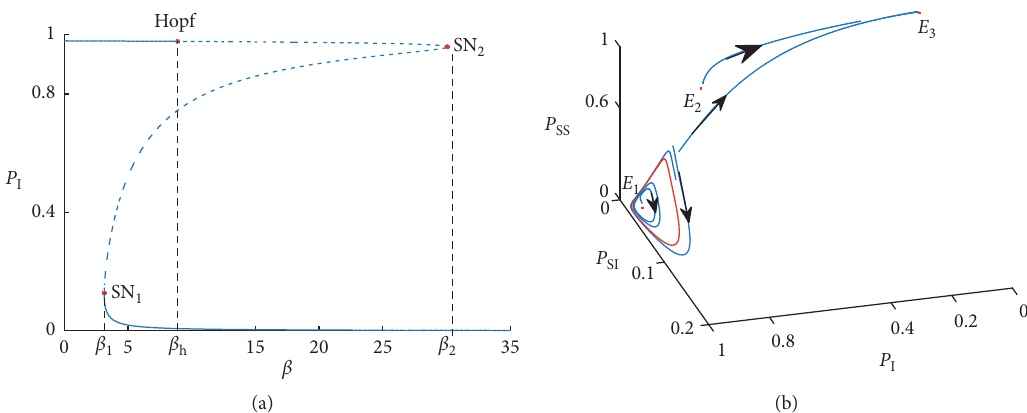
Figure 4: (a) Bifurcation diagram of equilibria. SN solid (dotted) curves represent stable (unstable) equilibrium states. The parameter values are τ � 0 . 5 , n � 6 , ω � 2 . 9 , and c � 0 . 05. (b) Coexistence of a stable cycle with a stable equilibrium. A stable cycle is shown by the red curve, and a stable equilibrium is represented by E where β � 9 . 60357 is close to β h shown in (a).